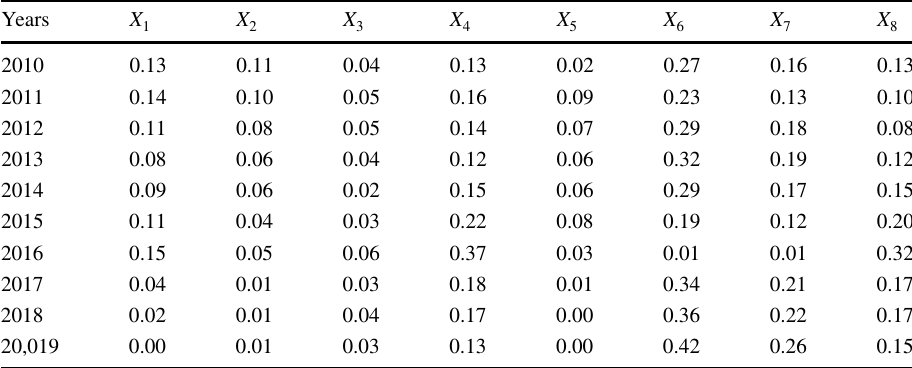
Table 5 The obstacle degree of water resources carrying capacity evaluation index in Henan